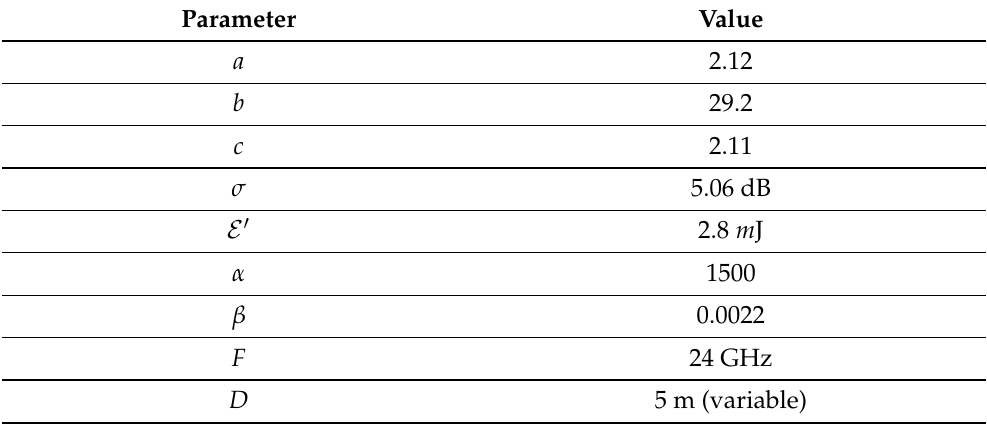
Table 1. Table for parameter value selections pertaining to the simulation environment.